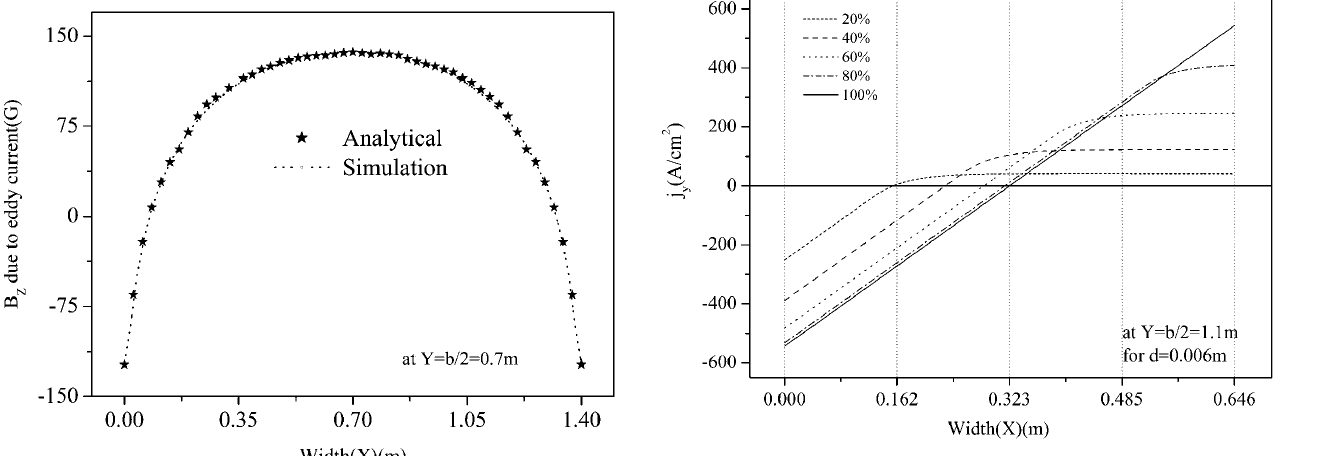
FIG. 13. Variation of the eddy current density, j ð G Þ due chamber is exposed to a nonuniform field as expressed in Eq. (2). z The uniform field (1.5 T) exposure zone ( c ) varies from 20%, 40%, 60%, 80%, and 100% of the width ( a ¼ 0 : 646 m ) of the